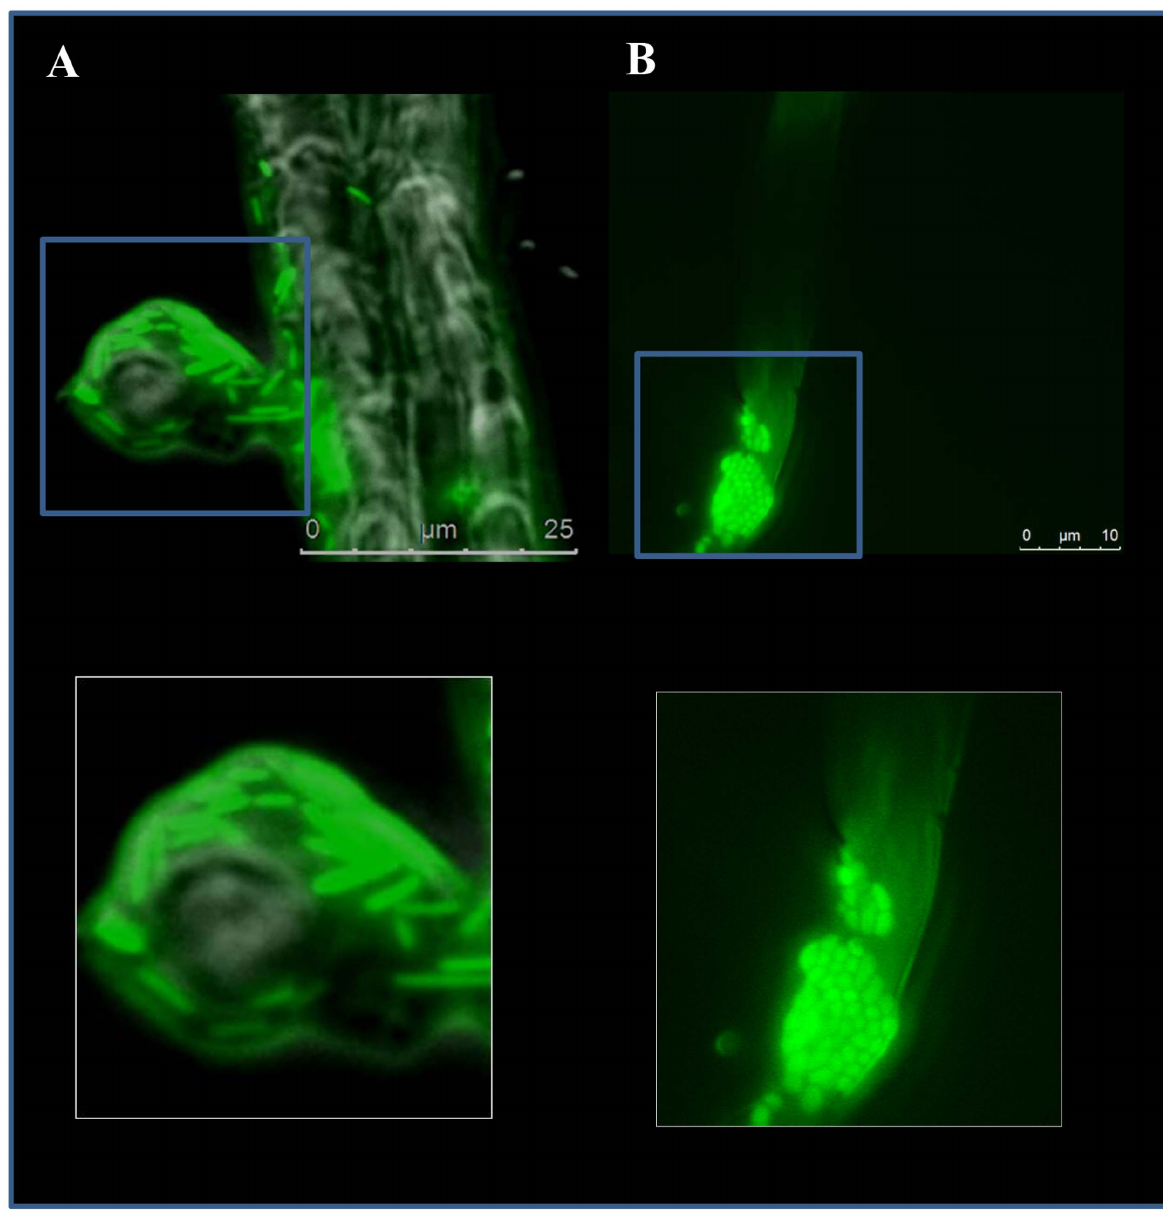
Figure 4. Images of rice roots inoculated with Azoarcus sp. CIB. Epifluorescence microscopy images of rice roots after 5 days (A) or 10 days (B) of inoculation with Azoarcus sp. CIB (pSEVA23GFP). A detail of each image is included (lower panels) to illustrate the morphological change of the cells.